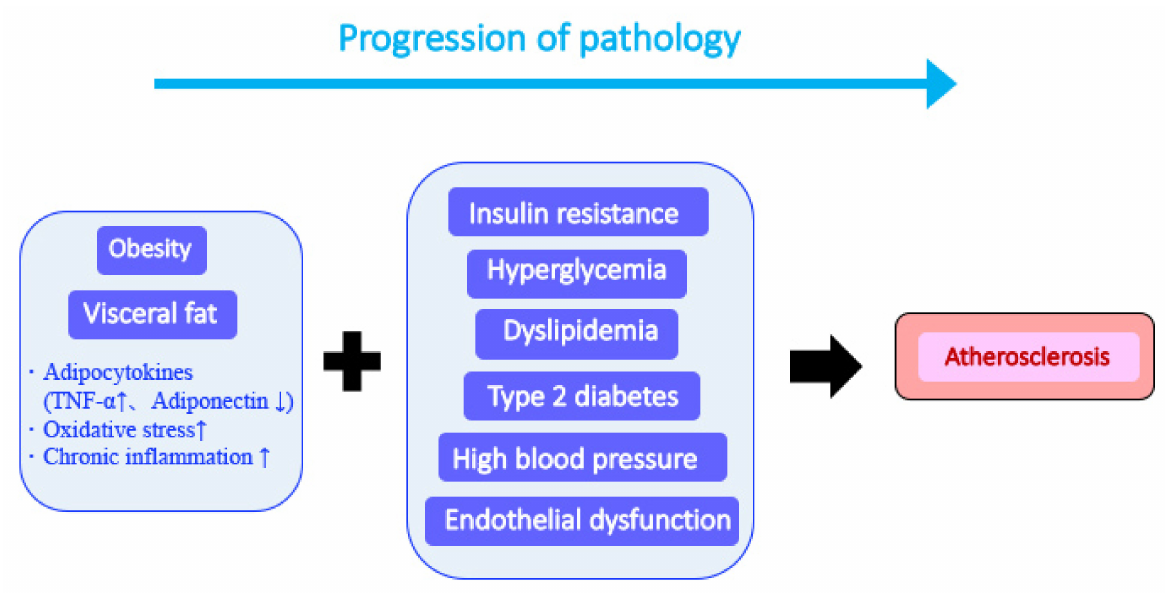
Figure 2. Progression from metabolic syndrome to arteriosclerosis. Obesity causes the excessive accumulation of visceral fat. Increased secretion of inflammatory cytokines such as tumor necrosis factor alpha from visceral fat and the strong induction of various diseases collectively cause